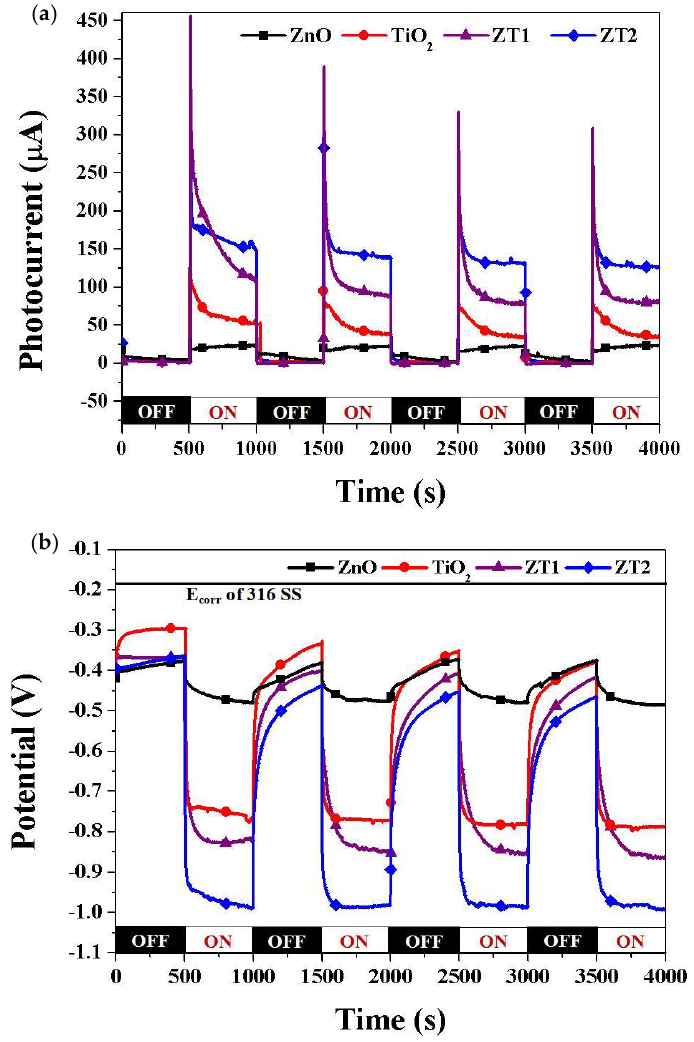
Figure 7. ( a ) Photocurrent density and ( b ) OCP of 316 SS electrode coupled with different films under intermittent simulated sunlight in 3.5 wt. % NaCl solution.